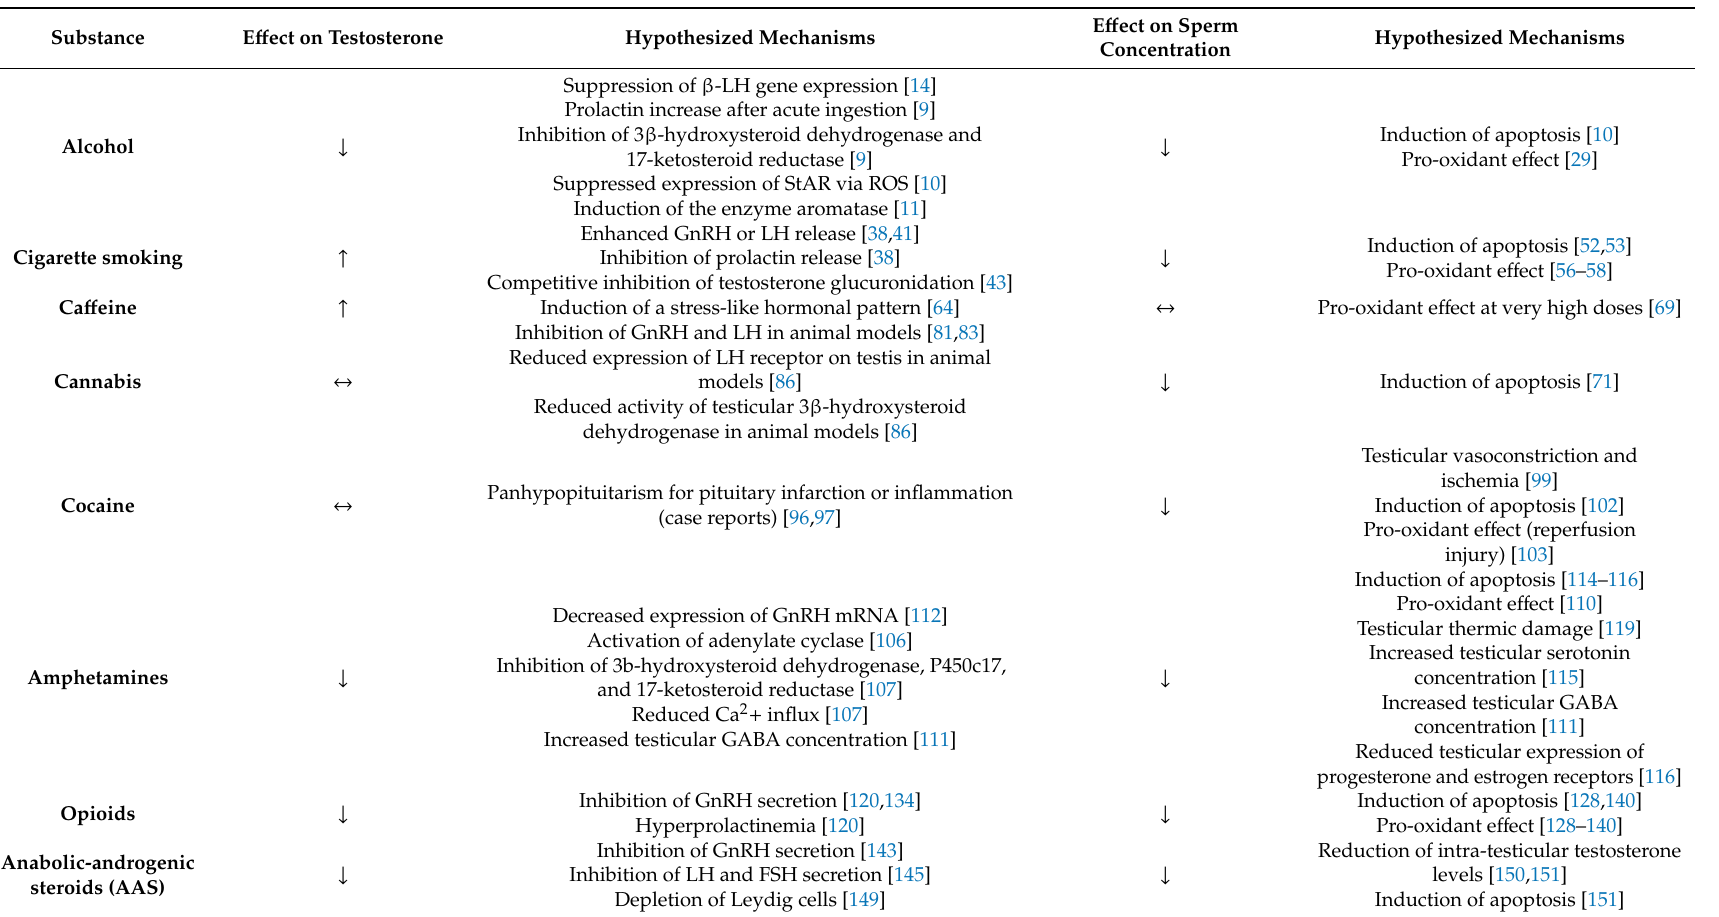
Table 1. E ff ects of each substance / drug on testosterone levels and sperm production, and main evidences of the pathophysiological mechanisms. ↑ : increase in testosterone / sperm concentration; ↓ : decrease in testosterone / sperm concentration; ↔ : no e ff ects on testosterone / sperm concentration; FSH: follicle-stimulating hormone; GABA: gamma-aminobutyric acid; GnRH: gonadotropin-releasing hormone, LH: luteinizing hormone; ROS: reactive oxygen species; StAR: steroidogenic acute regulatory